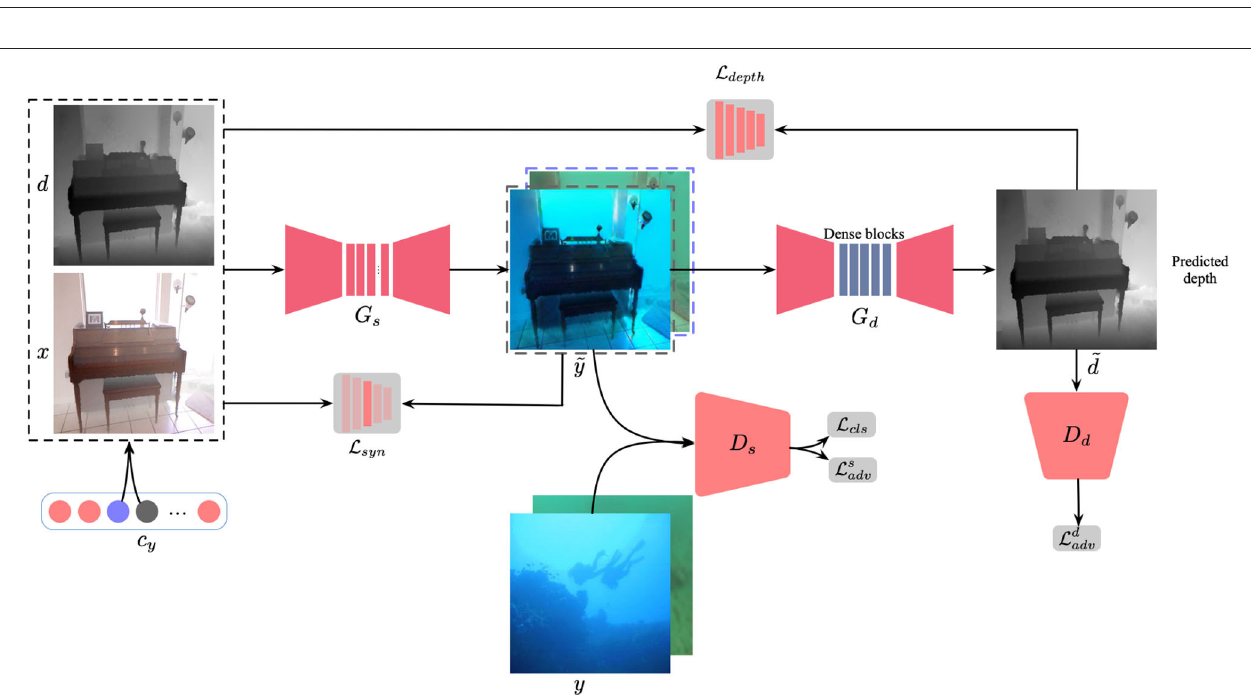
FIGURE 2 | The network framework of our proposed model is designed to synthesize multi-style underwater images and estimate underwater depth maps. The generator G s and the discriminator D s are used to synthesize multi-style underwater images, and the generator G d and discriminator D d learn to estimate underwater depth map based on the synthesized underwater RGB-D dataset.